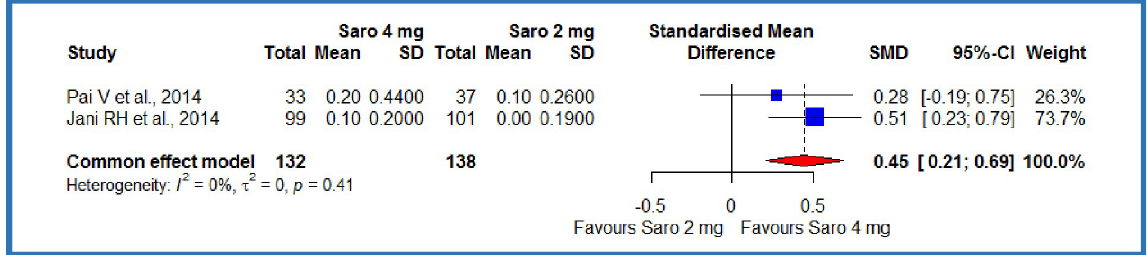
Fig 8. Forest plot of comparison of saroglitazar 4mg versus saroglitazar 2 mg on serum creatinine (mg/dL).